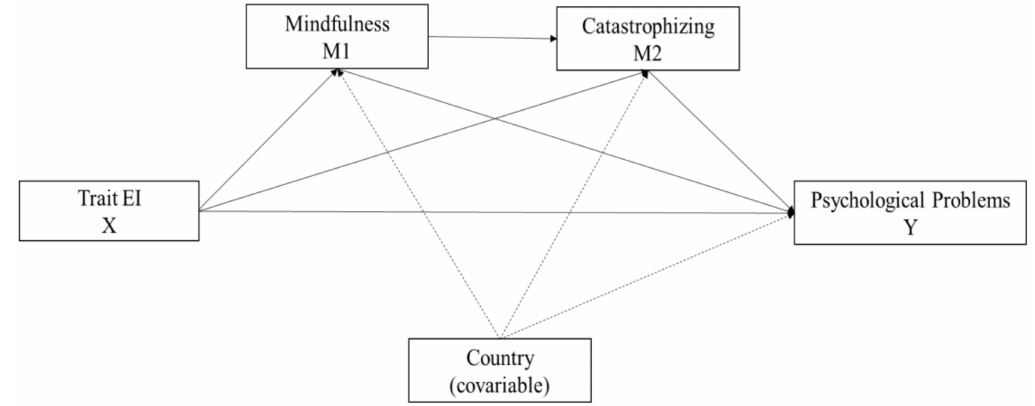
Figure 1. Conceptual and statistical diagram of Model 6 with 2 mediators plus a